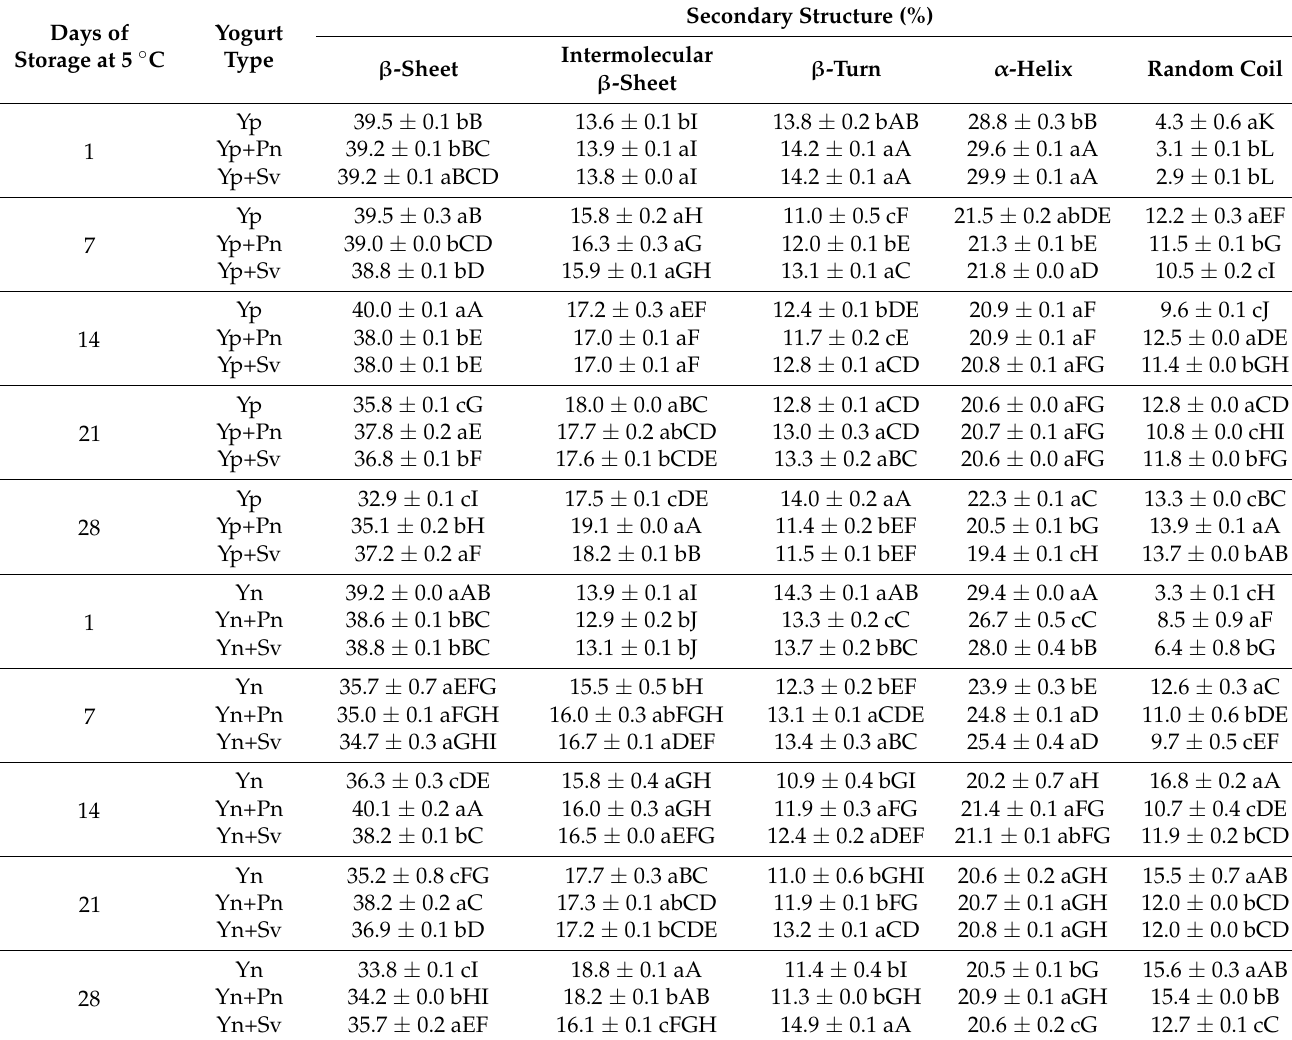
Table 6. Secondary structures of amide I band (QATR-FTIR) from probiotic (Yp) and natural (Yn) yogurt with or without scCO 2 /H 2 O extracts from P. nigra (Pn) and S. viminalis (Sv) during storage *. Days of Storage at 5 ◦